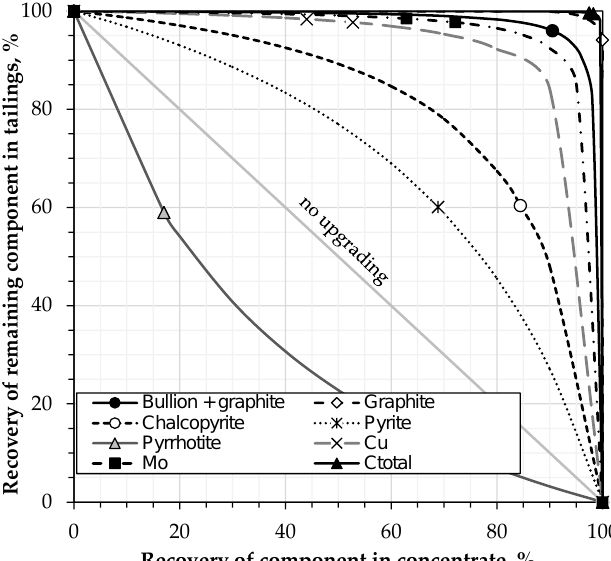
Figure 2. Recovery-recovery upgrading curves for flotation of the major minerals and metals.